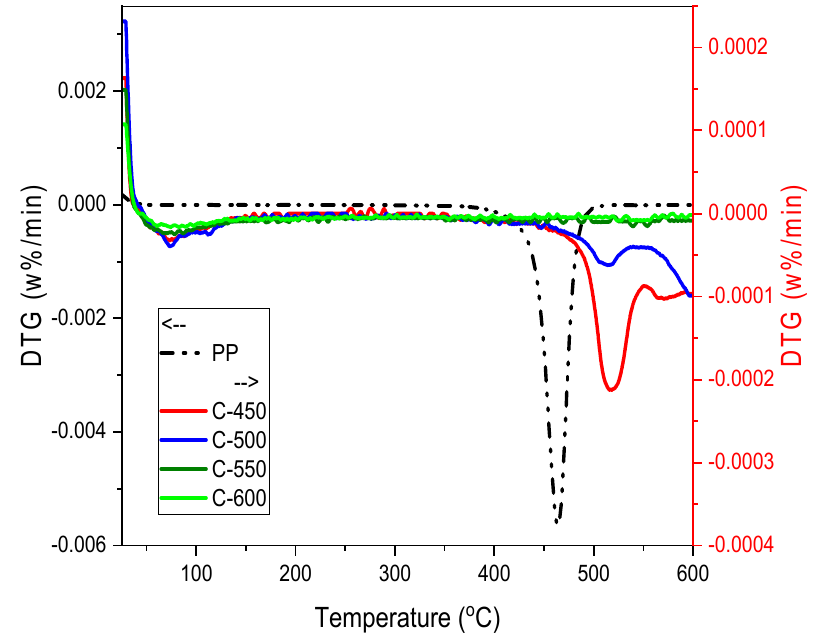
Figure 6. DTG curves for C-450, C-500, C-550 and C-600.